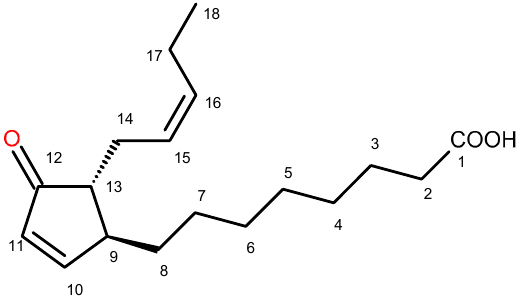
Figure 2. The chemical structure of ( + )-trans-12-oxo-phytodienoic acid (trans-12-OPDA) isolated from aerial parts of Carpesium divaricatum Sieb. & Zucc.